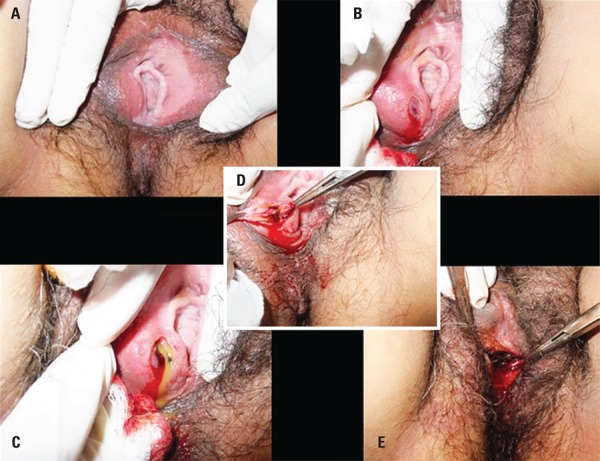
Procedimento a laser de CO2 no tratamento do cisto de Bartholin. (A) Exposição do cisto à direita, com infiltração com xilocaína a 2%. (B) Incisão com feixe laser focalizado sobre o cisto. (C) Abertura da cápsula com drenagem completa do conteúdo. (D) Reparo dos bordos com exposição da face interna da cápsula. (E) Vaporização da cápsula interna com laser raio desfocalizado